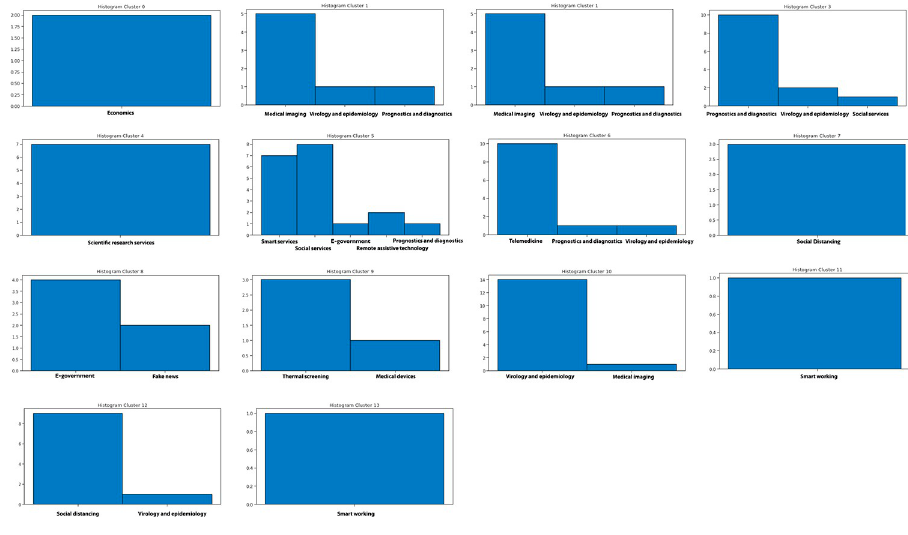
Fig 23. Details of clusters for